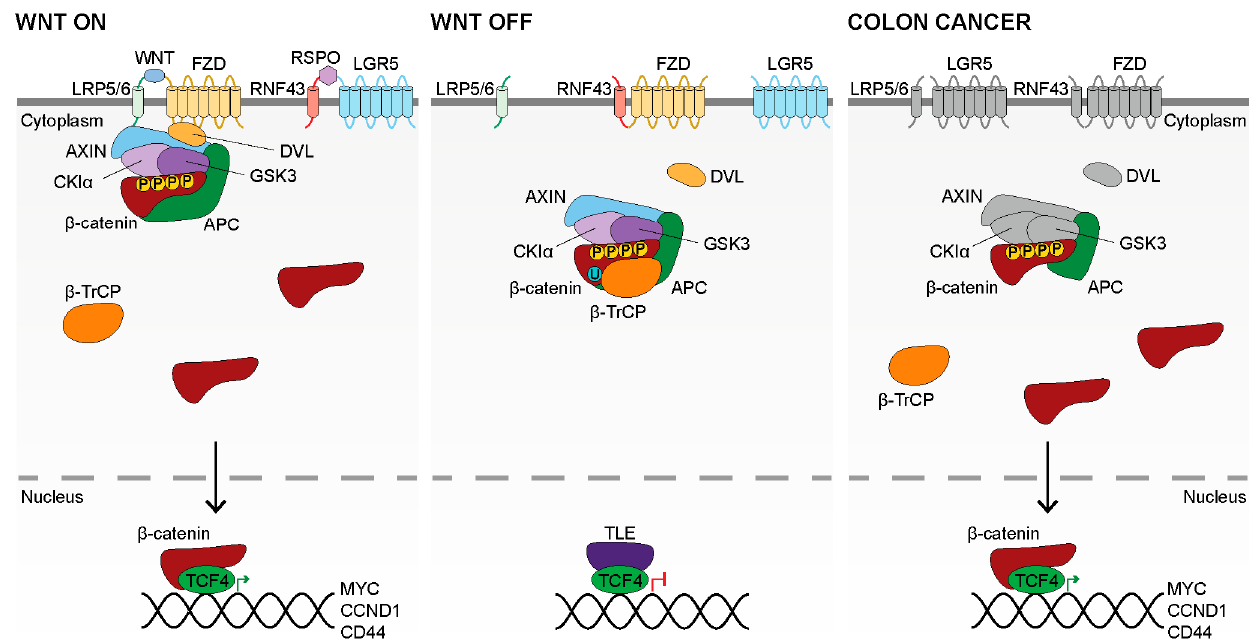
Figure 1. The WNT Signaling Pathway. In the WNT ON state ( left ), an R-spondin ligand (RSPO) binds LGR5 and RNF43/ZNRF3, preventing the inhibition of FZD. FZD is, therefore, able to bind a WNT ligand and LRP5/6 to form a co-receptor complex. DVL and AXIN, as well as the rest of the DC, is recruited to WNT–FZD–LRP at the plasma membrane. β -catenin may be phosphorylated within the sequestered DC, however, it cannot be ubiquitinated by β -TrCP, and is not degraded by the proteasome. The DCs become saturated with β -catenin, and newly synthesized β -catenin accumulates in the cytoplasm. β -catenin then migrates to the nucleus where it binds the TCF/LEF family of transcription factors (TCF4 in the intestines). The potent transcriptional activation domain of β -catenin, complexed with TCF4, results in the expression of WNT signaling target genes such as MYC , CCND1 , and CD44 . In the WNT OFF state ( center ), no WNT or RSPO ligands are present, and FZD is inhibited by RNF43/ZNRF3. The DC remains in the cytoplasm where it actively phosphorylates β -catenin. Phosphorylated β -catenin is recognized by β -TrCP and ubiquitinated, resulting in degradation of β -catenin (not diagrammed). β -catenin is unable to accumulate in the cytoplasm. The TCF/LEF factors are bound by the inhibitory TLE factors and repress target gene expression. In Colon Cancer ( right ), APC is truncated due to mutation, which compromises the ability of the DC to target β -catenin for degradation. The upstream components of the pathway are in grey as their functional role, to regulate β -catenin, has been compromised by APC truncation. β -catenin accumulates in the cytoplasm, after which it migrates to the nucleus. β -catenin binds the TCF/LEF transcription factors and constitutively activates the expression of WNT signaling target genes which leads to proliferation and the maintenance of stemness.